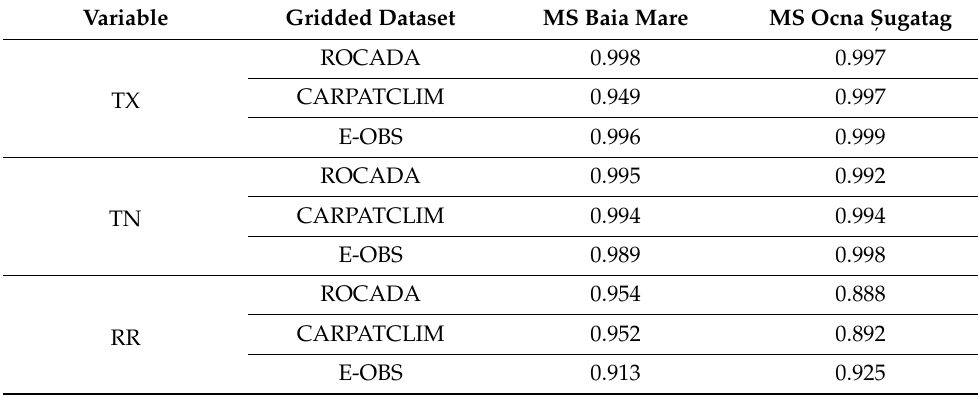
Table 4. Pearson’s correlation coefficient between gridded and observation data series for TX, TN, and RR